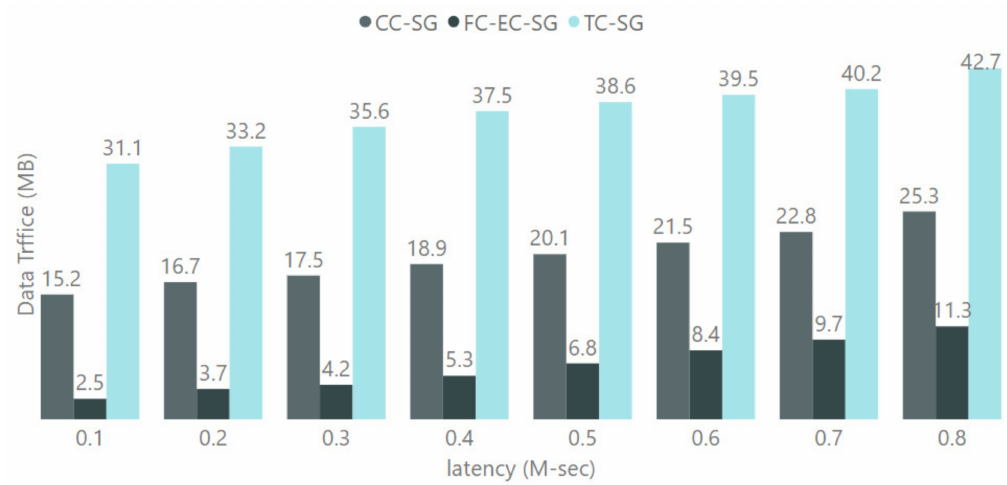
Figure 9. The average packet delay variation in CC-SG, FC-EC-SG, and